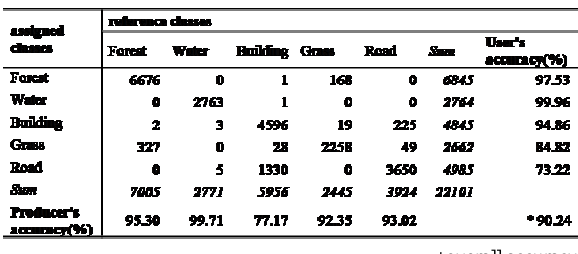
Table 1. Confusion matrix of original training data